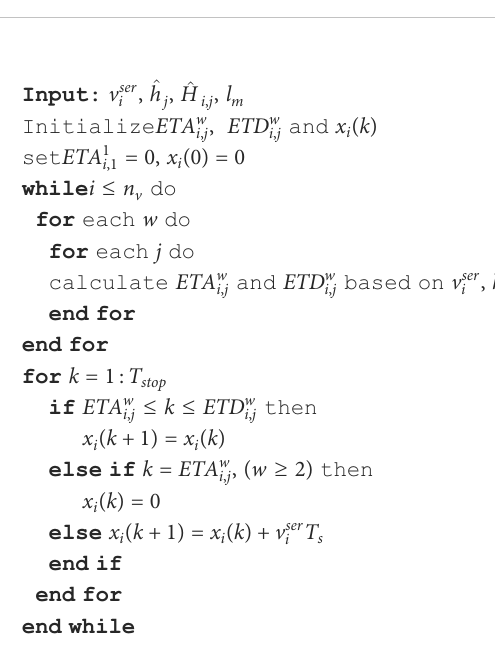
ALGORITHM 1 Reference trajectory generator